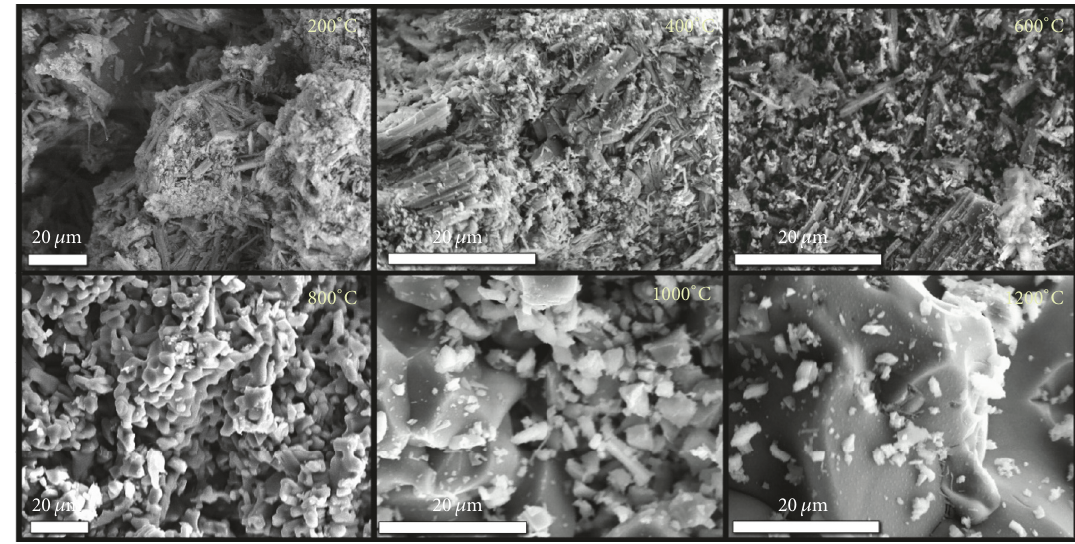
Figure 10: Several 3D printed square pieces of CaSO 4 were used to optimize the infiltration process with Ludox. All the samples were infiltrated with a solution of Ludox : water with a ratio of 1: 5 (wt) for 30 s and then dried for 10 min at 70 ∘ C and finally they were fired at the temperatures shown in the images for 2